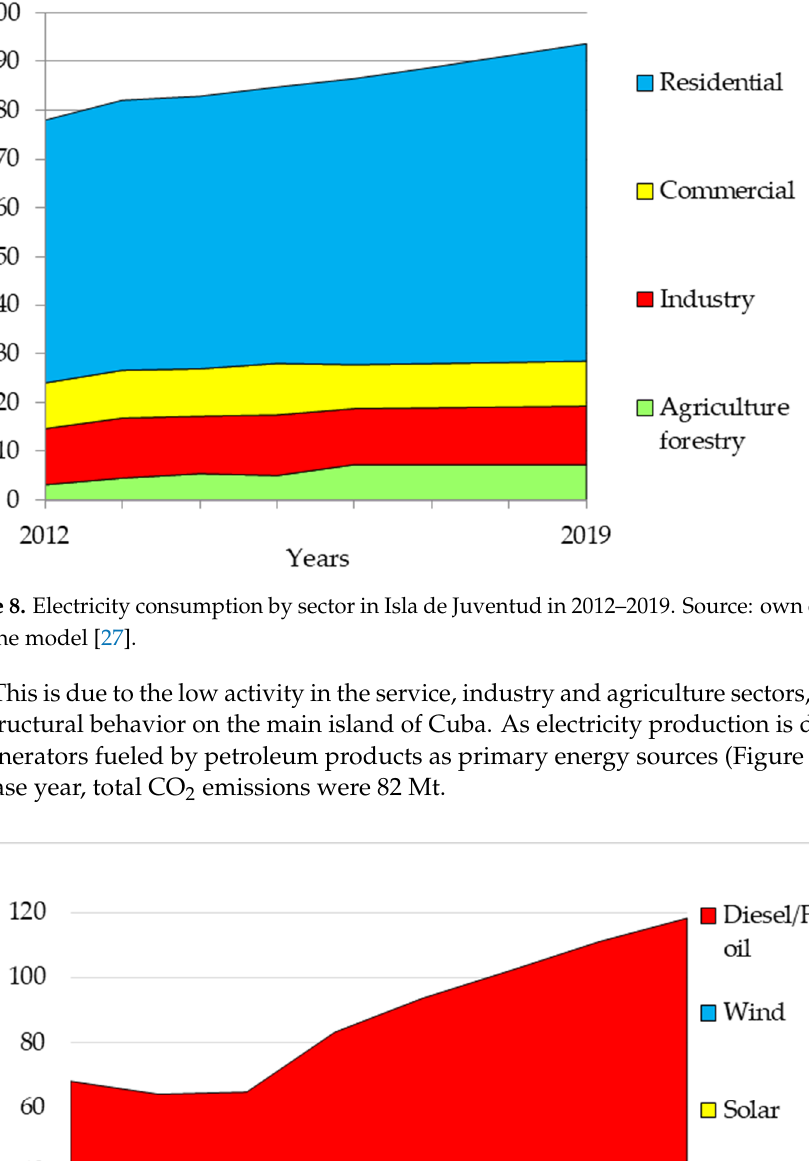
Figure 9. Electricity production in Isla de Juventud in 2012–2019. Source: own elaboration with the model [27].